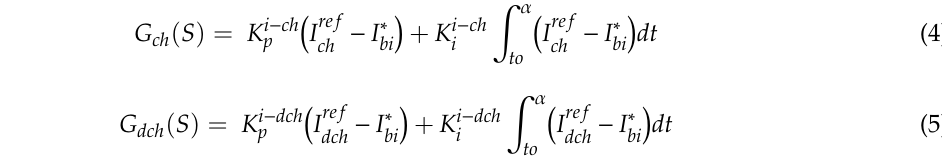
Figure 10. Impact of delay on the bidirectional converter switch S bi , C T = 4800 µ F and I m = 7.1 A: ( a ) in grid-tie, ( b ) with a 15 ms delay, and ( c ) with a 150 ms delay.